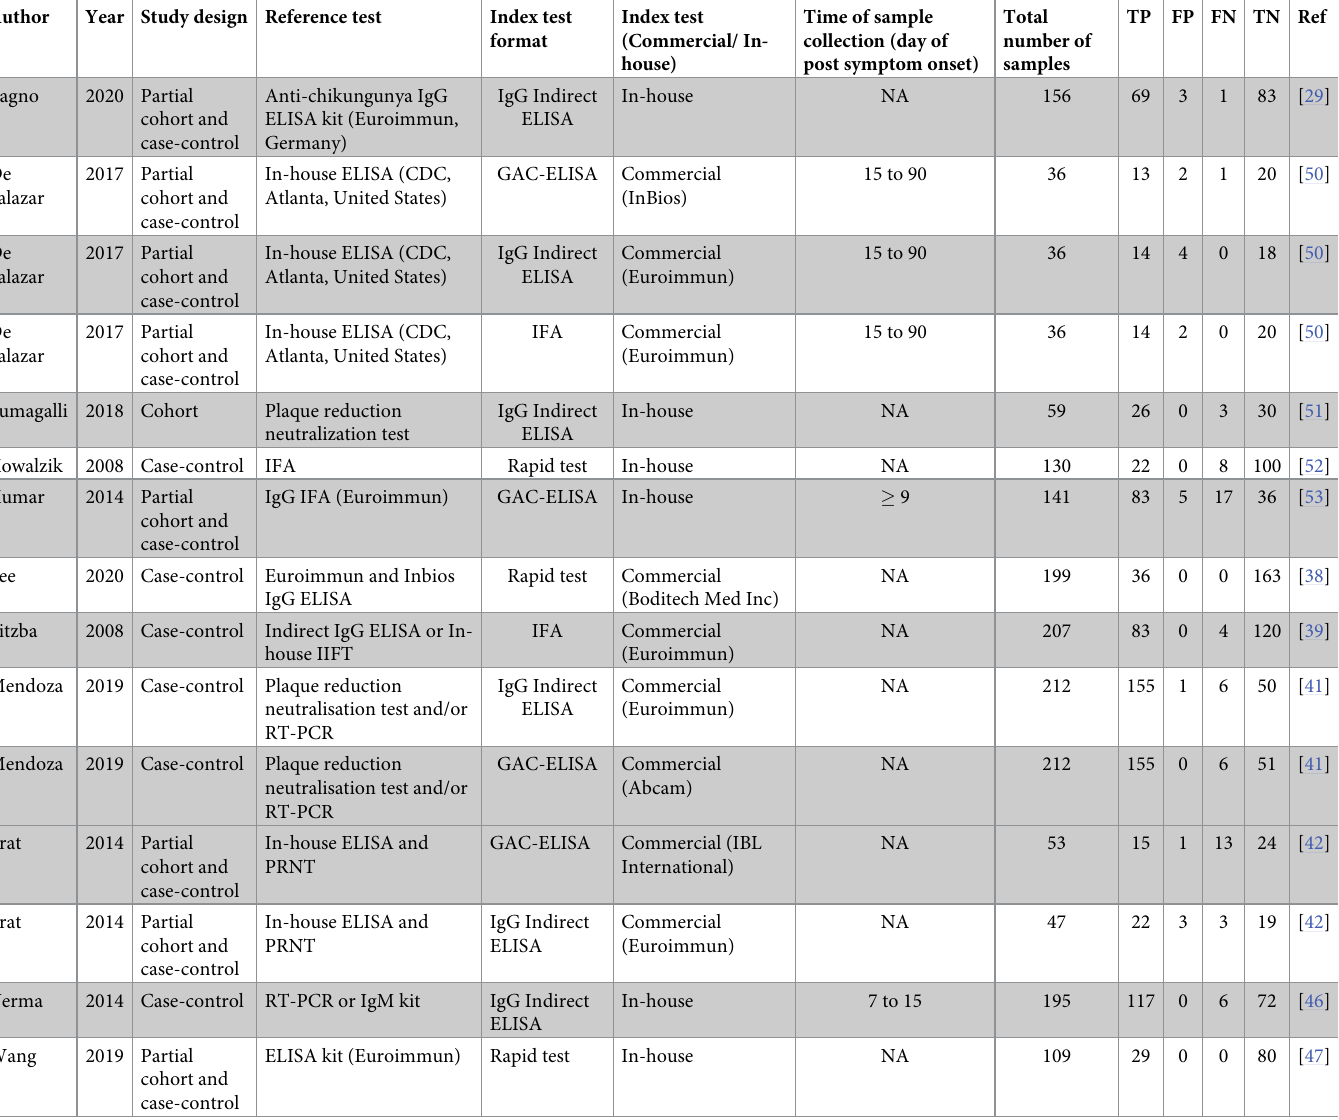
Table 3. Characteristics of studies on IgG detection tests included in the